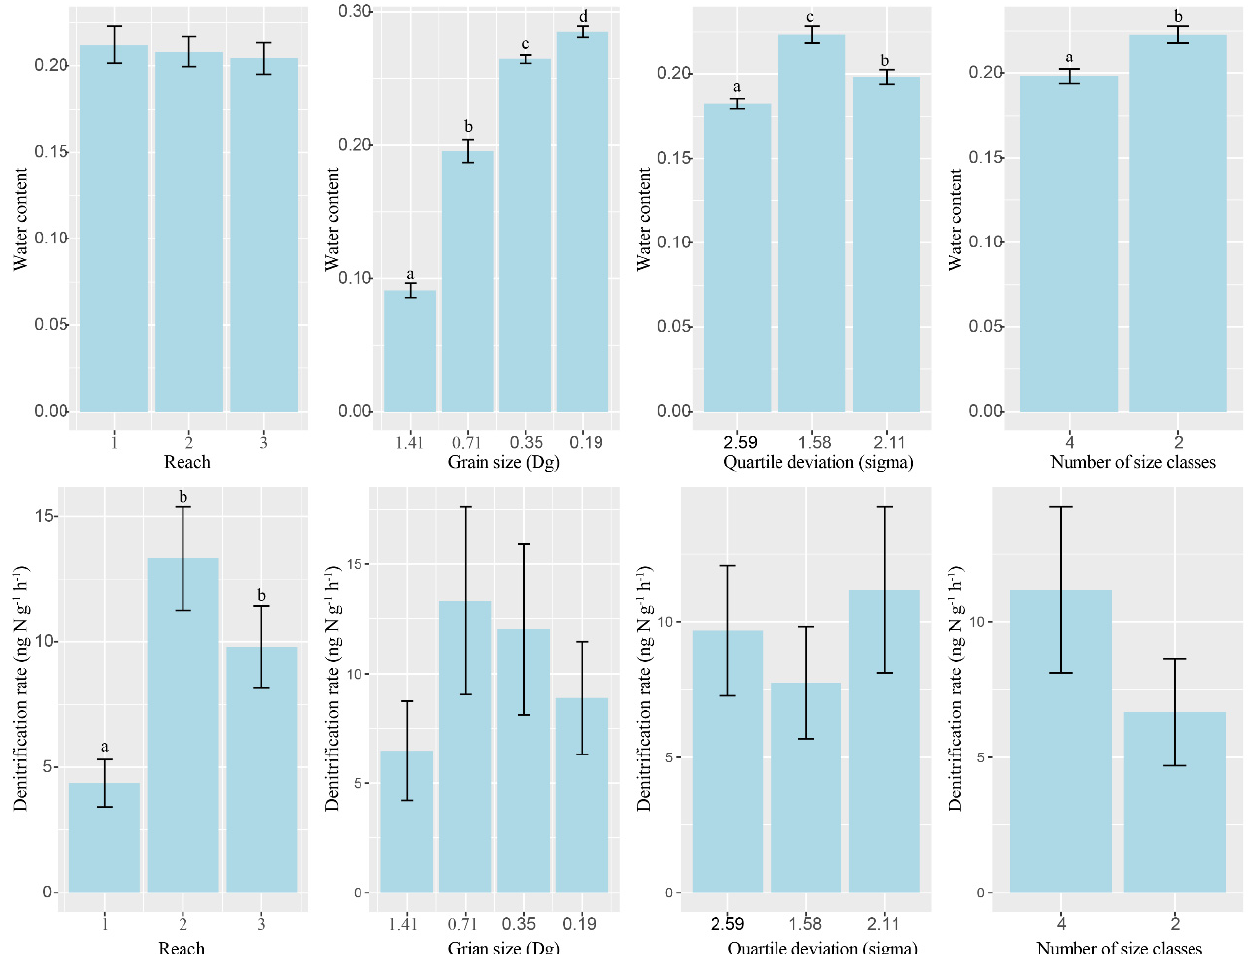
Figure 2. Different water contents and denitrification rates under different reaches and different particle sizes and heterogeneity. Different letters above the columns indicate significant differences ( p < 0.05).